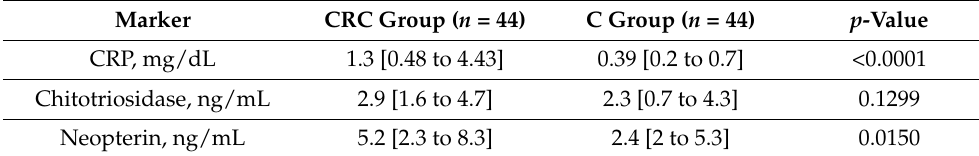
Table 2. Values of circulating markers according to the groups.